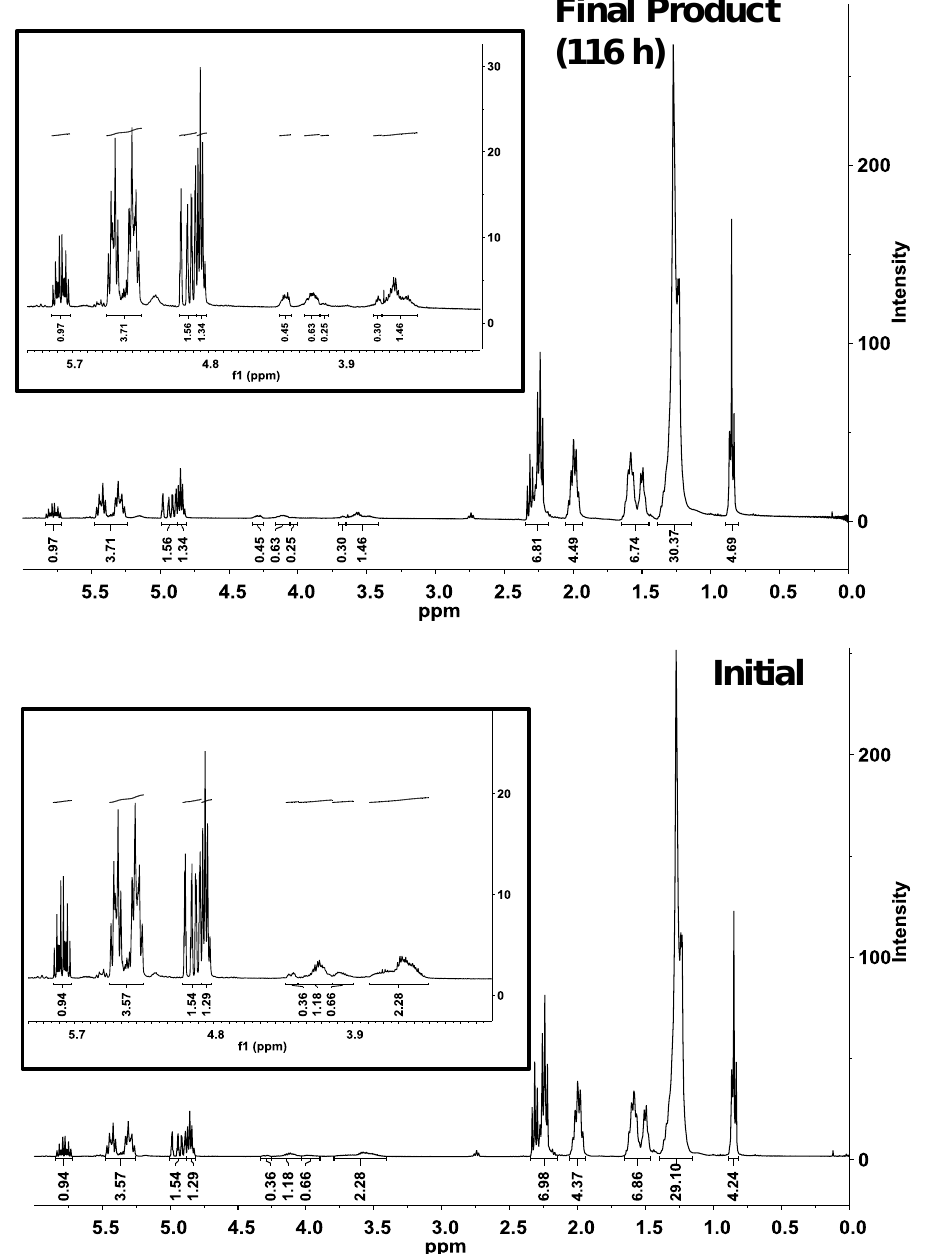
Figure 3. 1 H-NMR analysis of the CAL-catalyzed esterification of polyglycerol polyricinoleate ( PGPR ) and 10-undecenoic acid under initial and final conditions. Inset shows expanded view of 3–6 ppm region. Reaction conditions are given in Figure